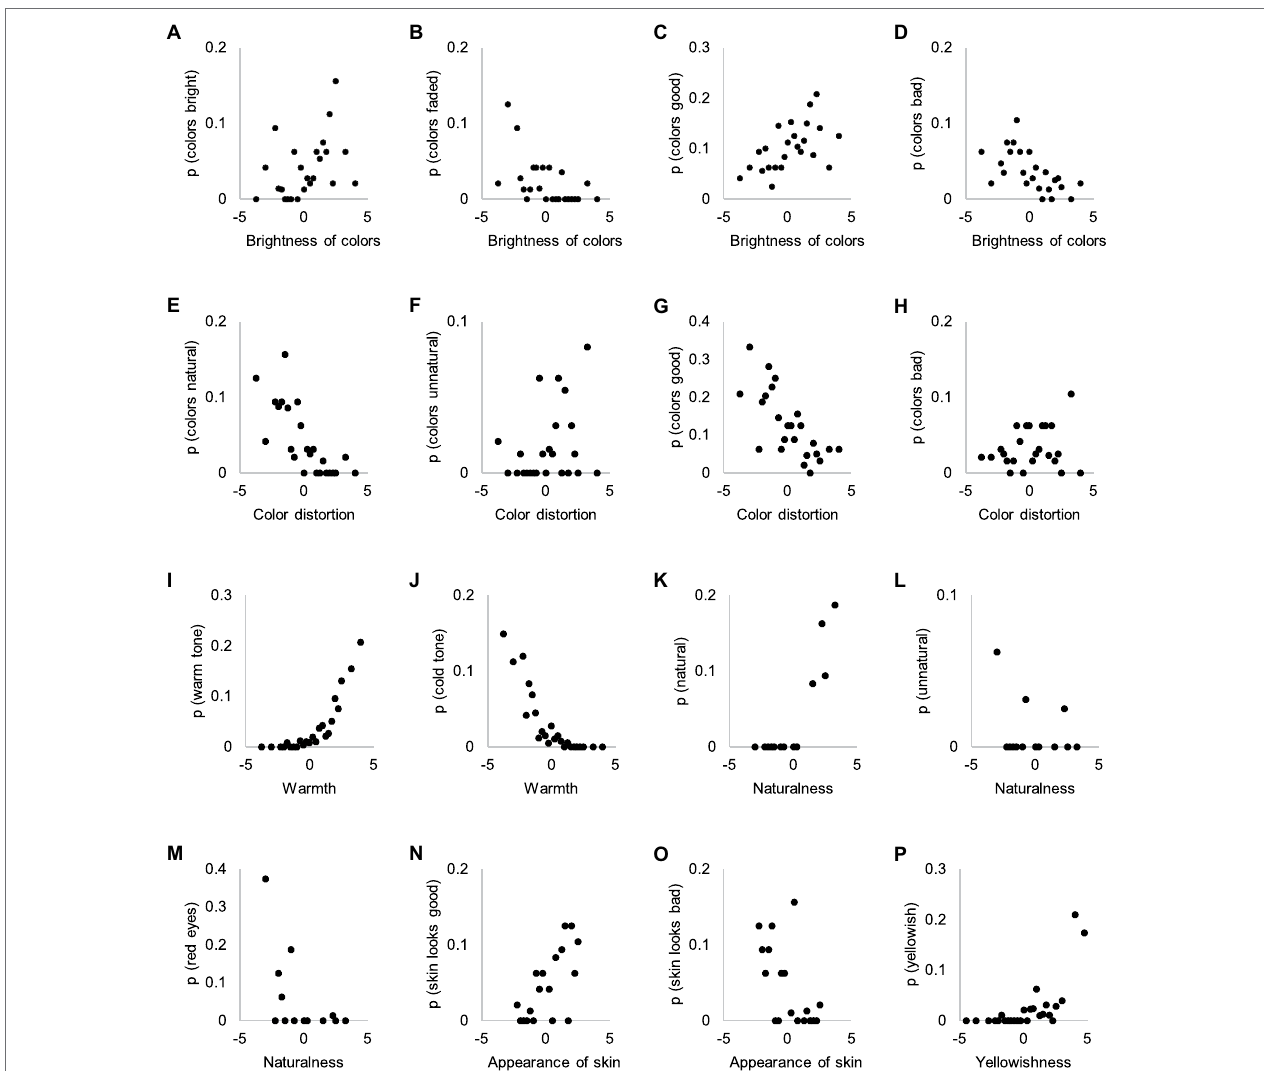
FIGURE 9 | Attributes referring to bright (A) , faded (B) , good (C,G) , bad (D,H) , natural (E) and unnatural colors (F) , as well as warm tone (I) , cold tone (J) , general naturalness (K,L) , red eyes (M) , appearance of skin (N,O) and yellowishness (P) in Experiments 1 and 2. The y-axis shows the probability of an attribute in Experiment 1 explanations and the x-axis the visibility of the attribute in Experiment